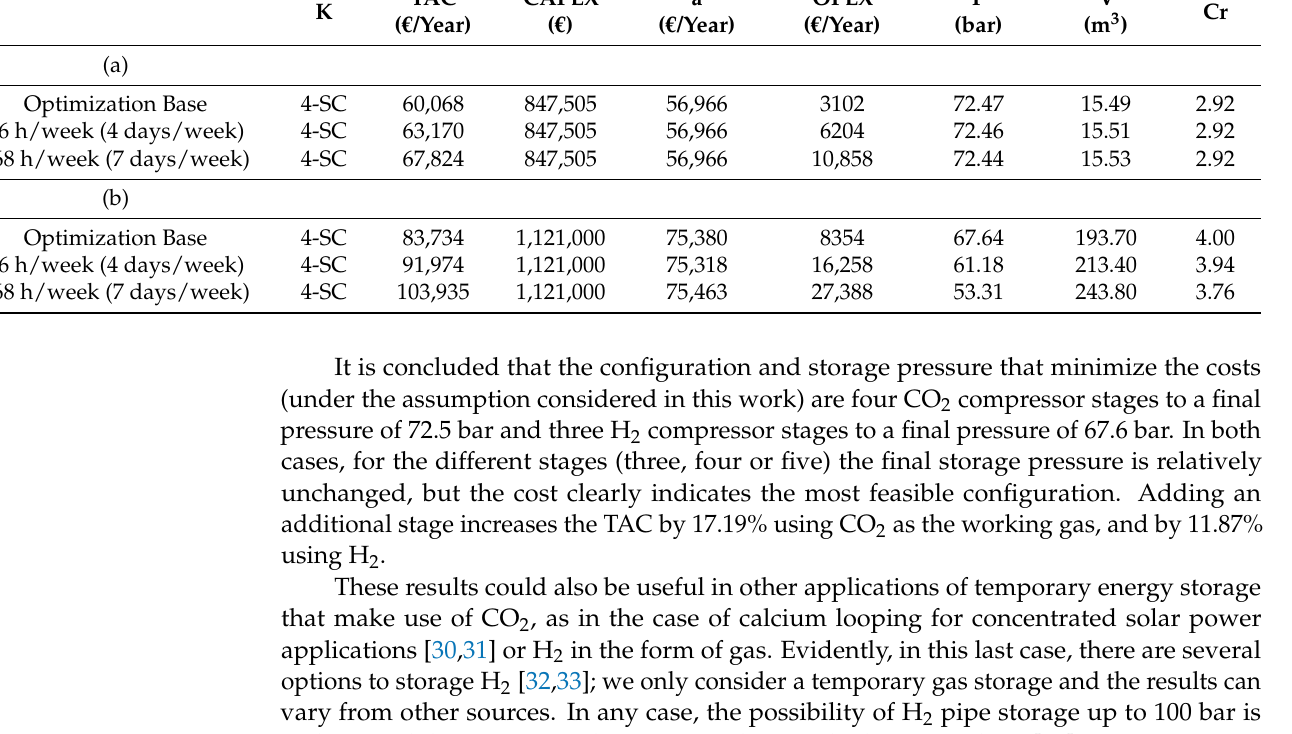
Table 11. Sensitivity analysis varying the operational hours in comparison to the optimized base case: (a) CO 2 ; (b) H 2 . K